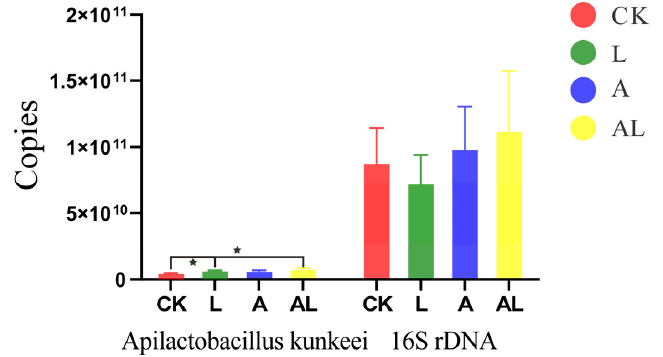
Figure 4. The total 16S gene and A. kunkeei copies of intestinal bacteria of honeybees. ‘*’ represents a statistically significant difference between two groups (independent ‐ sample t test, p < 0.05).